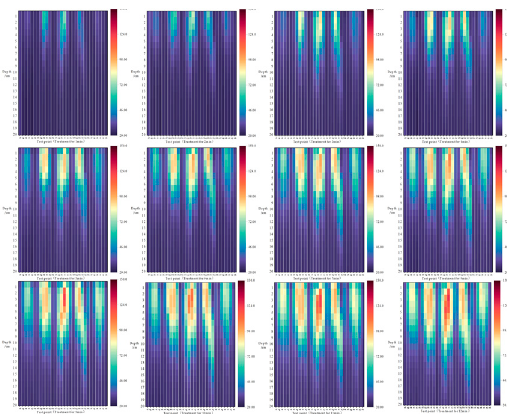
Figure 22. Heatmap of the internal temperature of 23% loess under microwave irradiation.